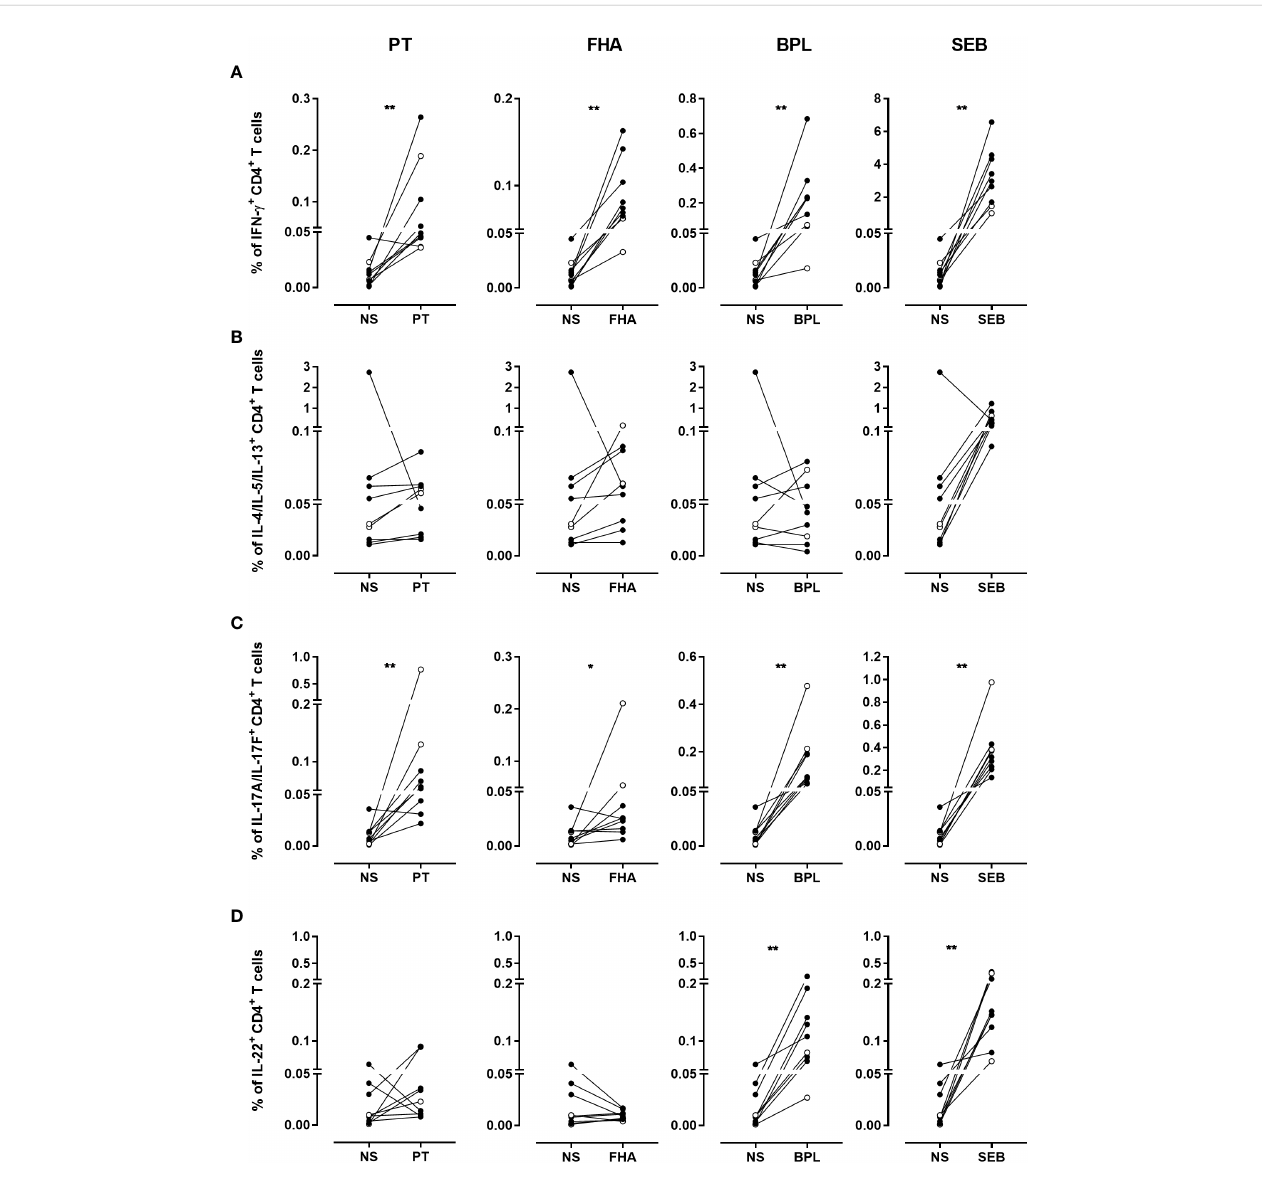
FIGURE 6 Frequencies of cytokine-producing CD4 + T cells in response to PT, FHA, BPL and SEB. The percentages of (A) IFN- g -, (B) IL-4/IL-5/IL-13-, (C) IL-17A/IL- 17F- and (D) IL-22- producing CD4 + T cells in cryopreserved samples after stimulation with PT, FHA, BPL or SEB are compared to those obtained in the absence of antigen (NS). Diluted blood was incubated during 24 hrs with 5 µg/ml PT, 5 µg/ml FHA or 10µg/ml BPL. Negative and SEB positive controls were used in parallel. The comparison is performed for seven adults (black circles) (n°6-12), and two 5-6 years-old children (open circles), all recently aP vaccine boosted. The cryopreserved cells were processed for intracellular staining as described in Figure 5, and stained with antibody panel 2 (Table 1). The acquisition was performed on a LSR Fortessa fl ow cytometer and FlowJo software (version 9.5.3) was used for the analysis. Comparisons were performed by using the Wilcoxon matched-pairs signed rank test with Graphpad Prism 7.03 software. * p <0.05; ** p